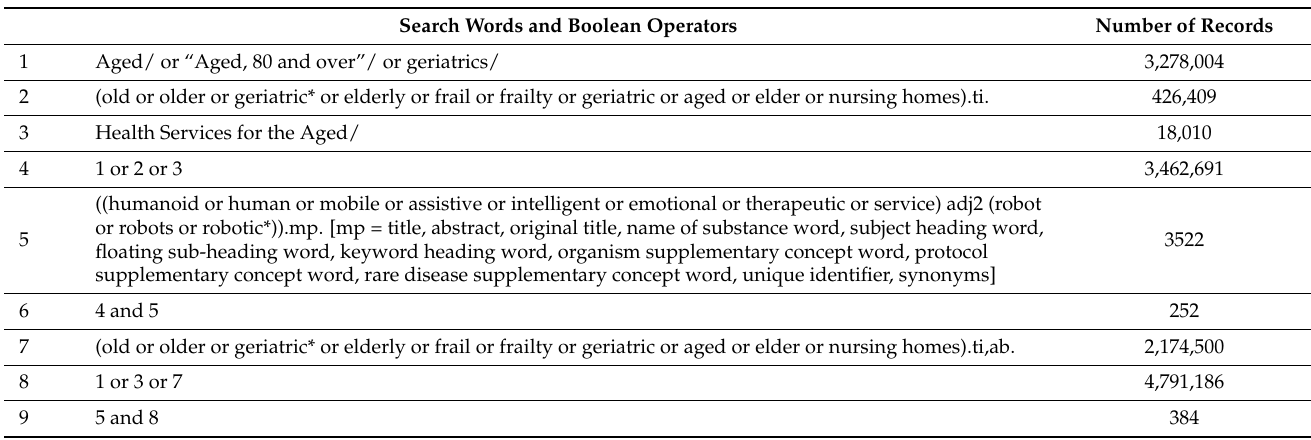
Table 2. Example of search string in Ovid MEDLINE